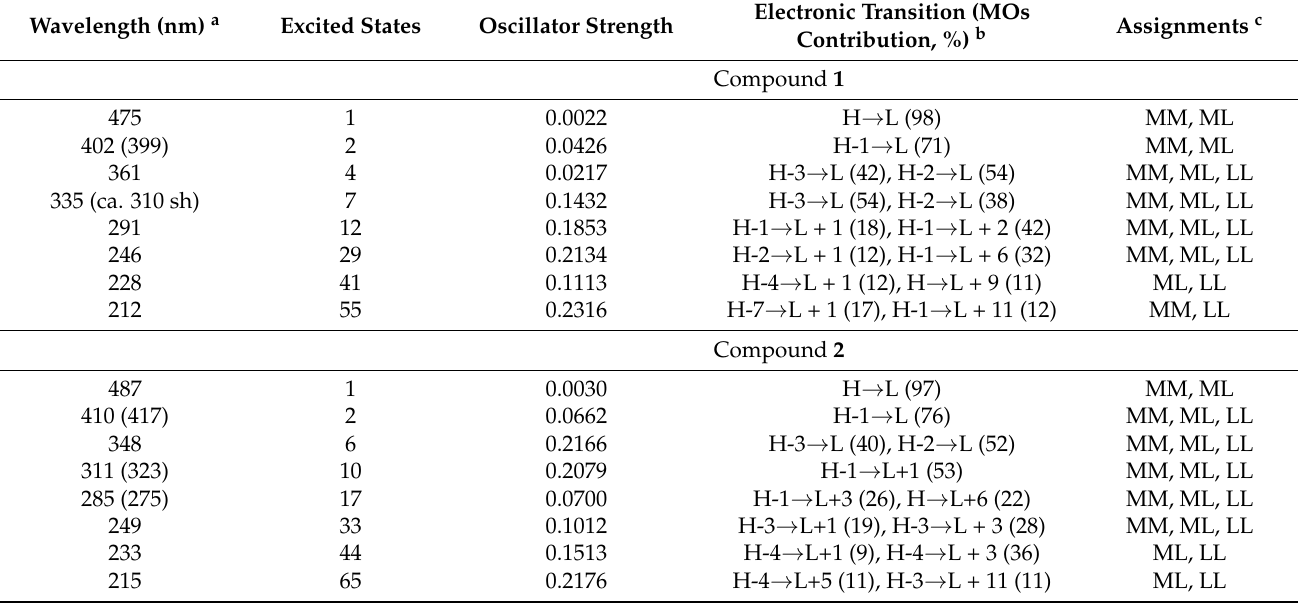
Figure 3. Experimental and simulated spectra for compounds 1 (0.20 mM) and 2 (0.08 mM) in chloroform (spectra simulated at B3LYP/SDD with PCM in chloroform). Gaussian band shape with exponential half-width s = 0.16 eV. Table 2. Selected excited state properties and assignments for 1 and 2 , calculated at B3LYP/SDD with PCM in chloroform.